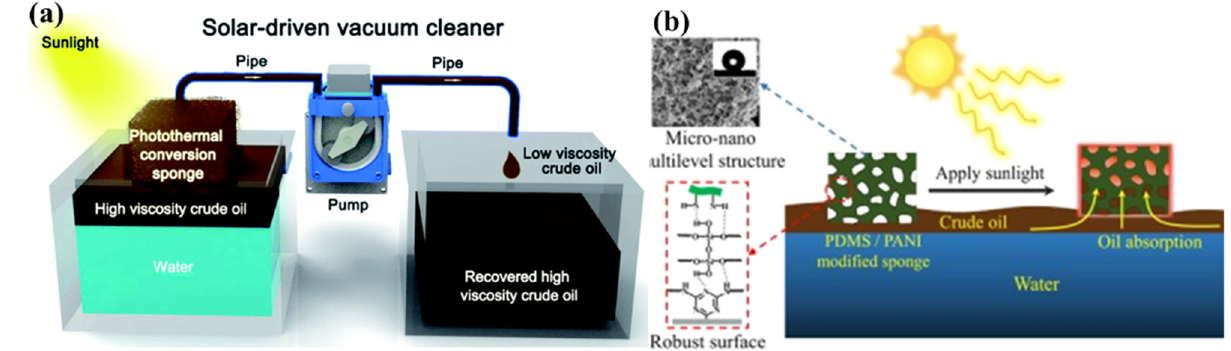
Figure 2: ( a ) Schematic illustration of the solar - driven vacuum cleaner [ 58 ] . ( b ) Schematic diagram of PDMS/PANI photothermal conversion crude oil adsorption [ 59 ] .